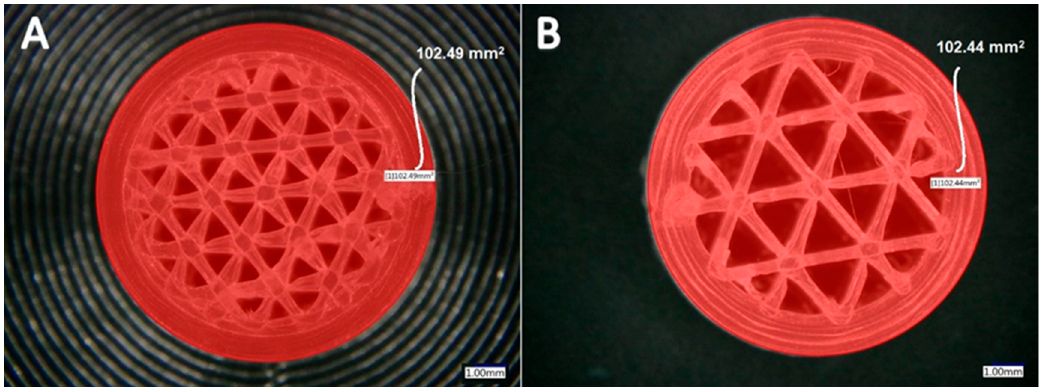
Figure 4. Area measurement of infill lines: (A) 1.6 mm ILD, (B) 2.4 mm ILD.